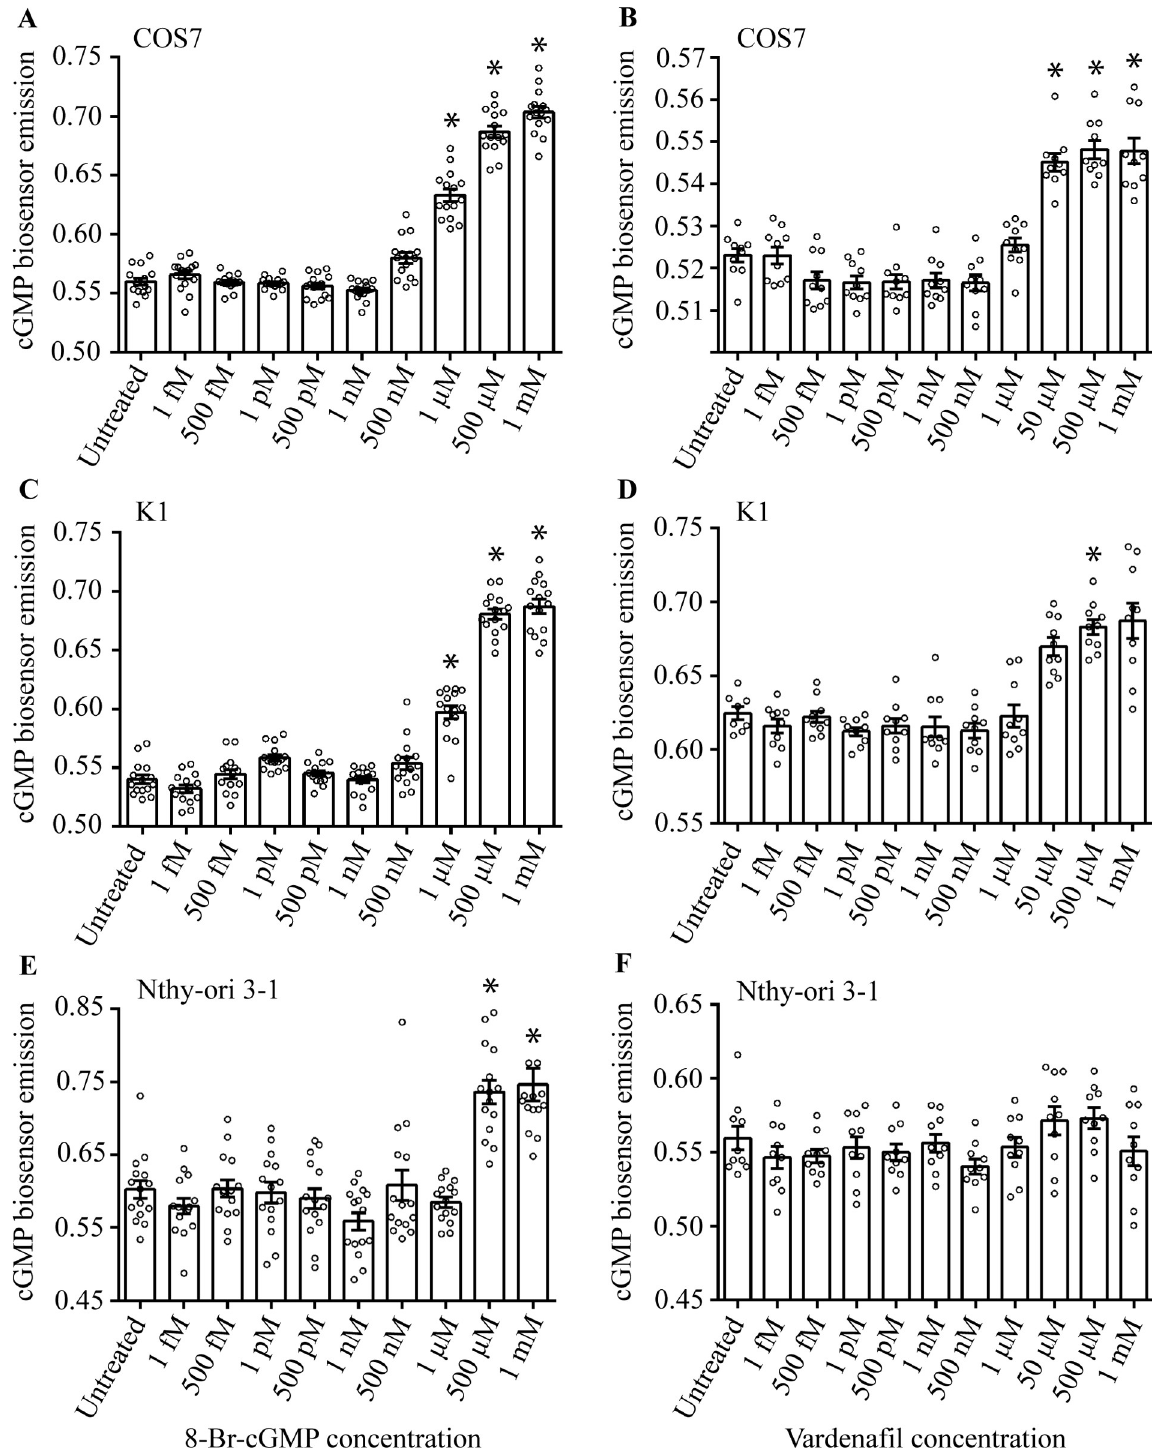
Fig 1. Analysis of intracellular cGMP levels. Transfected cells expressing the cGMP/Rluc-tagged biosensor were treated 2 h with increasing 8-Br-cGMP and vardenafil (fM-mM range). BRET signals indicating intracellular cGMP levels were evaluated and plotted against the concentration of inhibitor/analog. A, B) Data from the COS7 cell line treated with 8-Br-cGMP and vardenafil, respectively; C, D) 8-Br-cGMP- and vardenafil-treated K1 cell line; E, F) Nthy-ori 3–1 cells treated with 8-Br-cGMP and vardenafil. Results were compared by Kruskal Wallis test and Dunn’s post-test versus untreated samples and statistically significant differences were marked by � (p < 0.05; means ± SEM; n = 8 to 15).